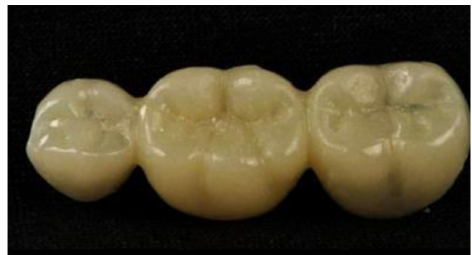
Figure 6. Milled provisional restorations.